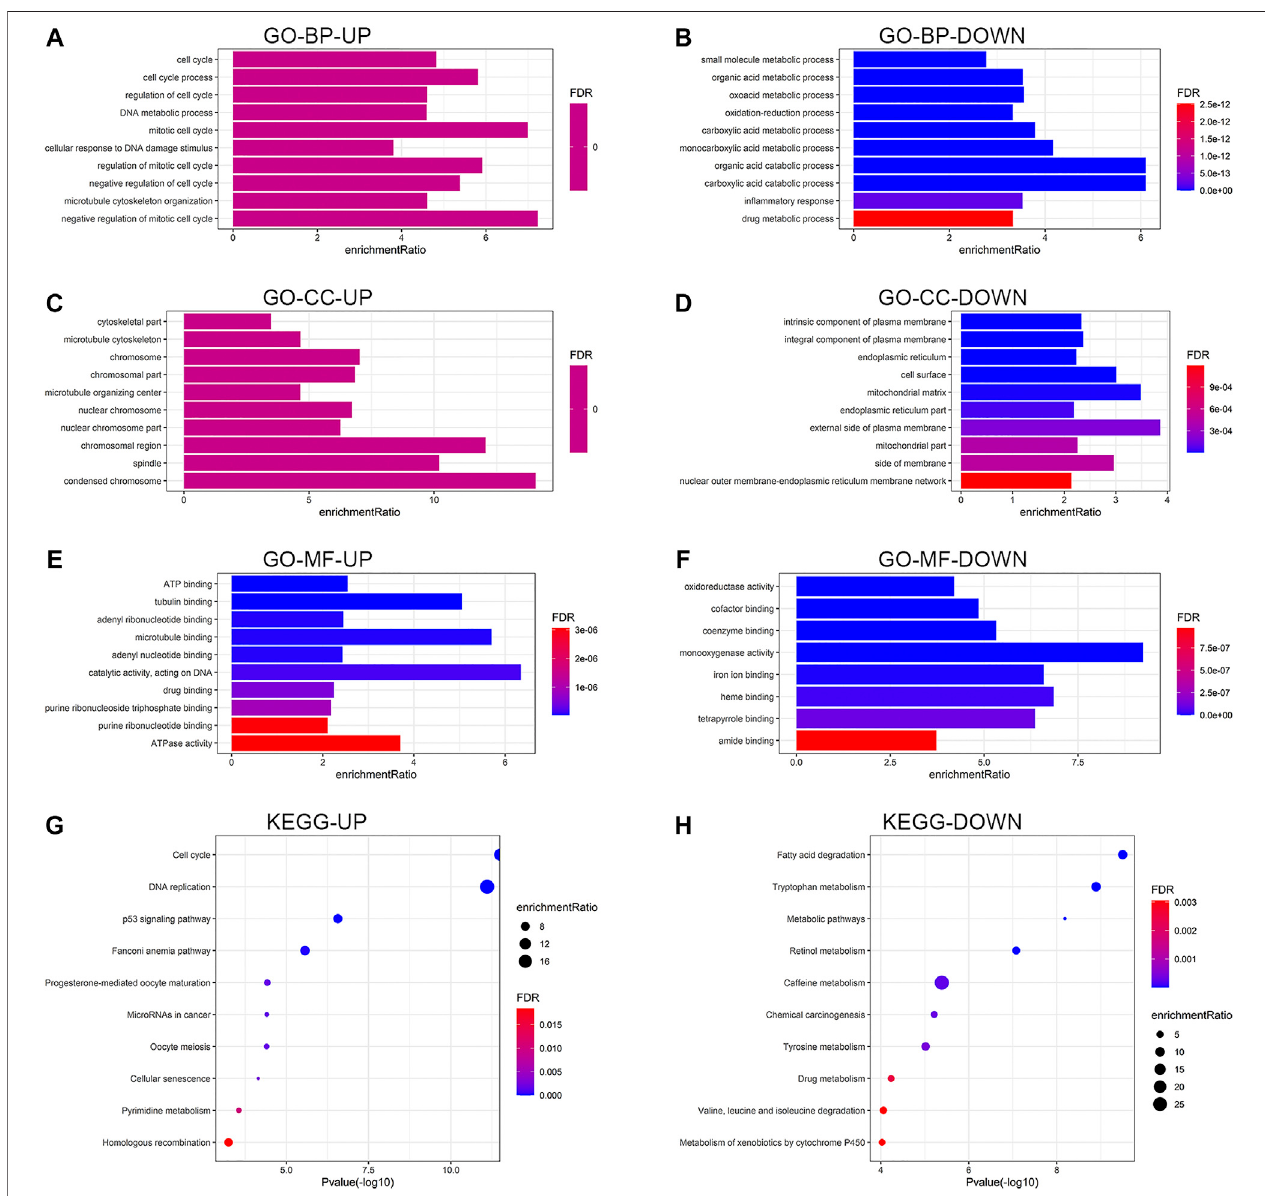
FIGURE 3 | Functional enrichment analysis of the upregulated and downregulated DEGs. Results of GO enrichment analysis of the DEGs, including BP (A,B) , CC (C,D) , and MF (E,F) . (G,H) Results of KEGG pathway analysis of the DEGs. DEGs, differentially expressed genes; GO, Gene Ontology; BP, biological process; CC, cellular component, MF, molecular function; KEGG, Kyoto Encyclopedia of Genes and Genomes; UP, upregulated; DOWN, downregulated; FDR, false discovery